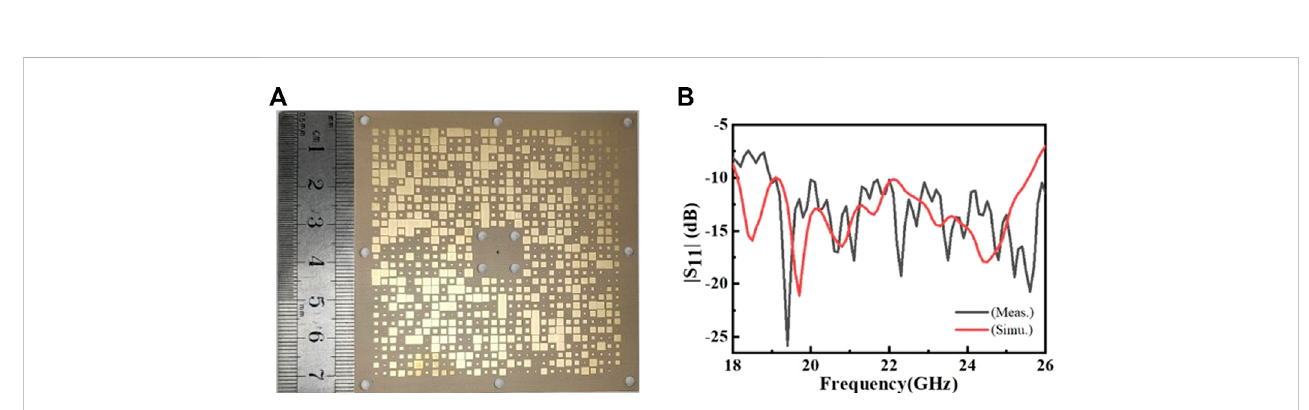
FIGURE 2 (A) Fabricated FDHM antenna. (B) Simulated and measured | S 11 |.